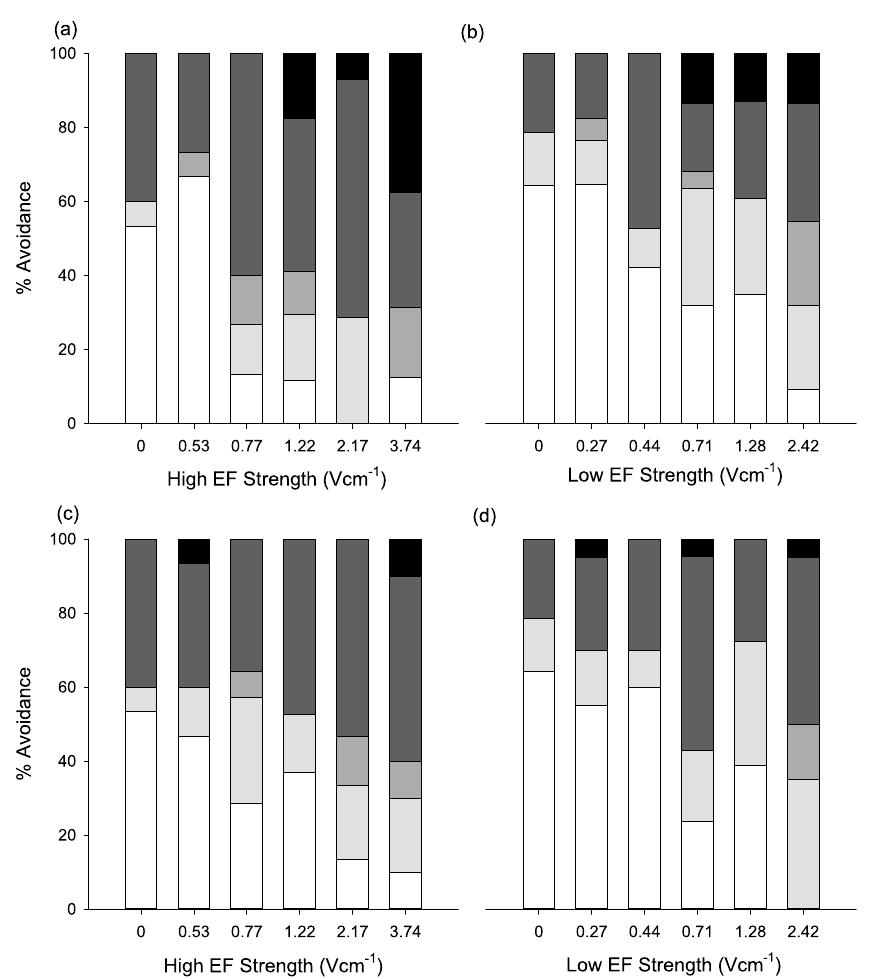
Fig 6. Influence of field strength and pulse frequency on the avoidance response exhibited by upstream moving juvenile eel in the HEF or LEF route. (a) HEF, 2 Hz, (b) LEF, 2 Hz, (c) HEF, 10 Hz and (d) LEF, 10 Hz. Clear, light grey, mid grey, dark grey and solid bars correspond to no change , acceleration , retraction , switching and rejection , respectively.